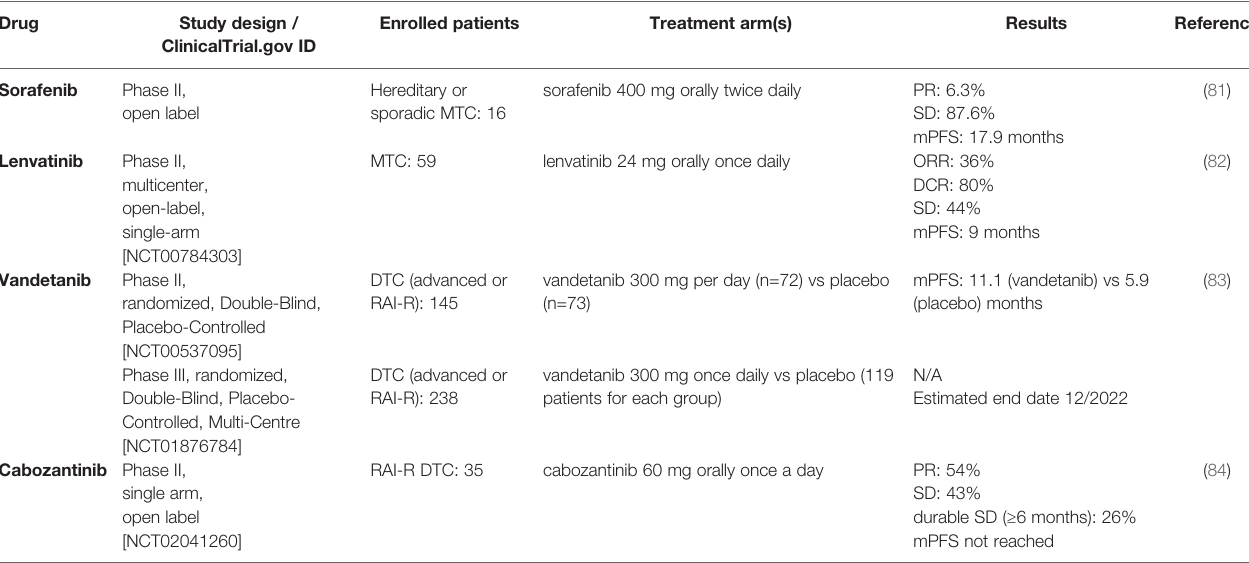
TABLE 6 | Not-approved use of sorafenib, lenvatinib, vandetanib and cabozantinib. Drug